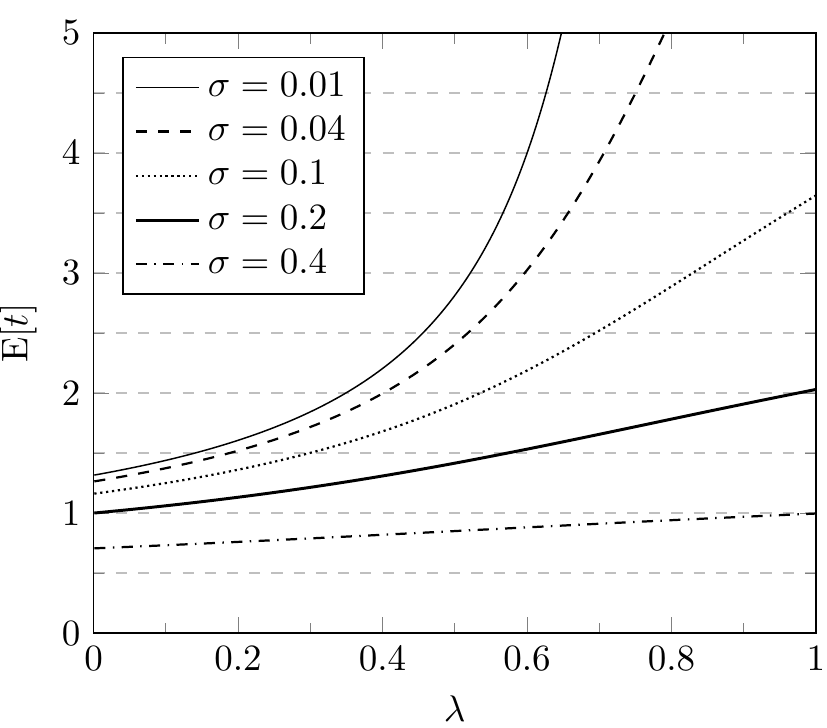
Figure 3. Mean sojourn time E [ t ] versus λ , for Poisson arrivals, geometric service times with µ = 0.75 and different values of σ .